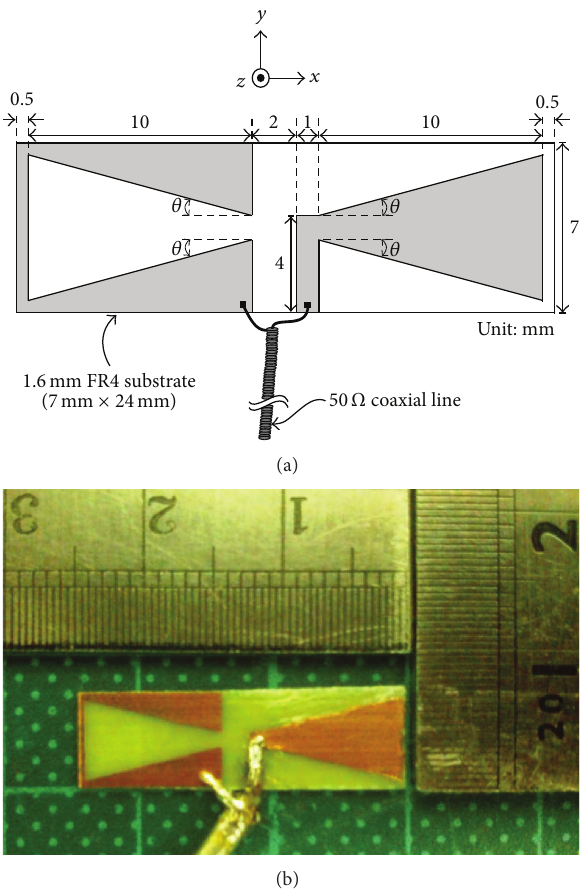
Figure 1: (a) Geometry and (b) photograph of proposed dual-band dipole antenna for WLAN applications.